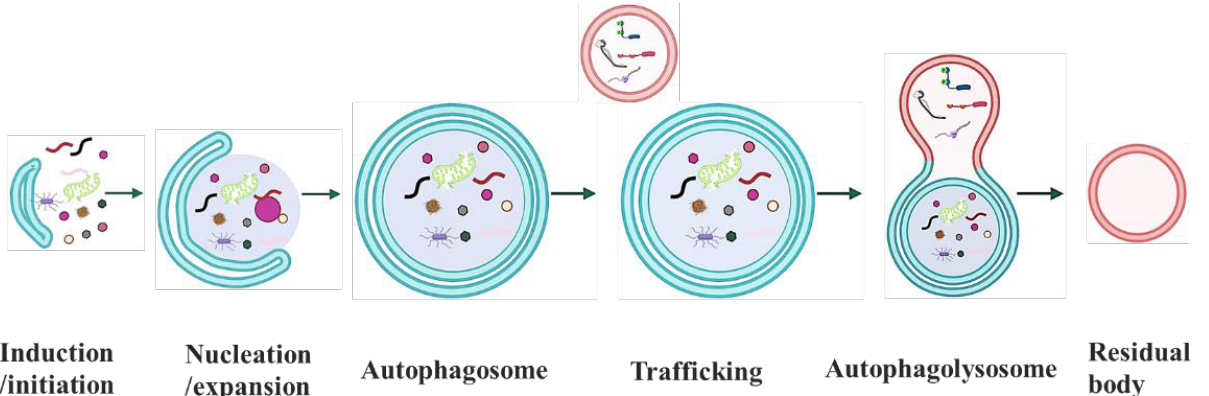
Figure 2. Schematic for macroautophagy. Macroautophagy is a multistep process that involves the induction/initiation, nucleation/expansion, maturation, trafficking of autophagosome, formation of autophagolysosome, and release and reuse of degradation products.